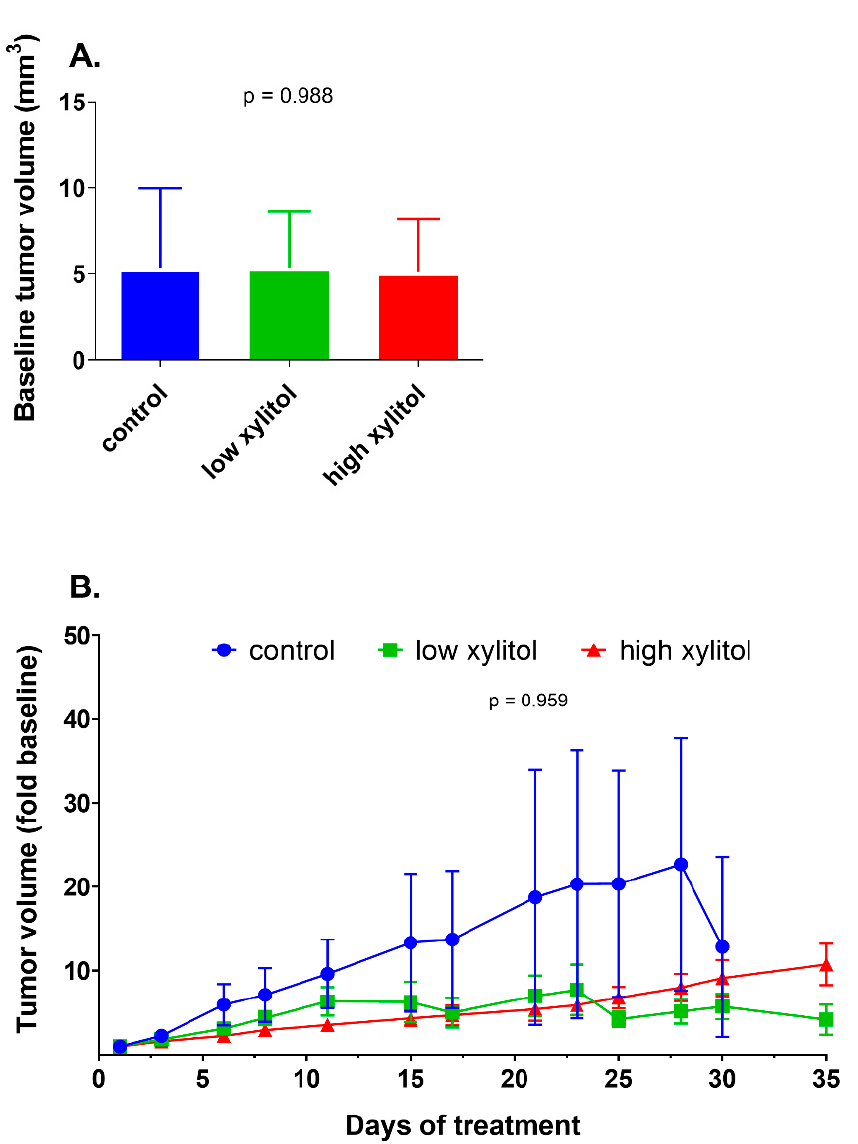
Figure 5. Tumor volumes: ( A ) Baseline tumor volume of CAL-27 xenograft mice given the glucose solution ( (cid:4) control), low-xylitol solution ( (cid:4) ), and high-xylitol solution ( (cid:4) ). Results are shown as mean ± SD. p -value was obtained from one-way ANOVA. ( B ) Baseline fold change of tumor volume, results are shown as mean ± SEM. p -values were obtained from a two-way ANOVA. As shown in Figure 6, the median survival times for control, low-, and high-xylitol groups were 19, 20, and 30.5 days, respectively. The analysis shows that the percent survival of mice given low xylitol and high xylitol was higher than those of the control group. Statistical analyses demonstrated that treatment with a high dose of xylitol significantly prolonged the survival time when compared with the control group ( p = 0.0105). Such dose is equivalent to 0.1–0.2 g/kg body weight or 10 g/day in humans, which is the household use dose